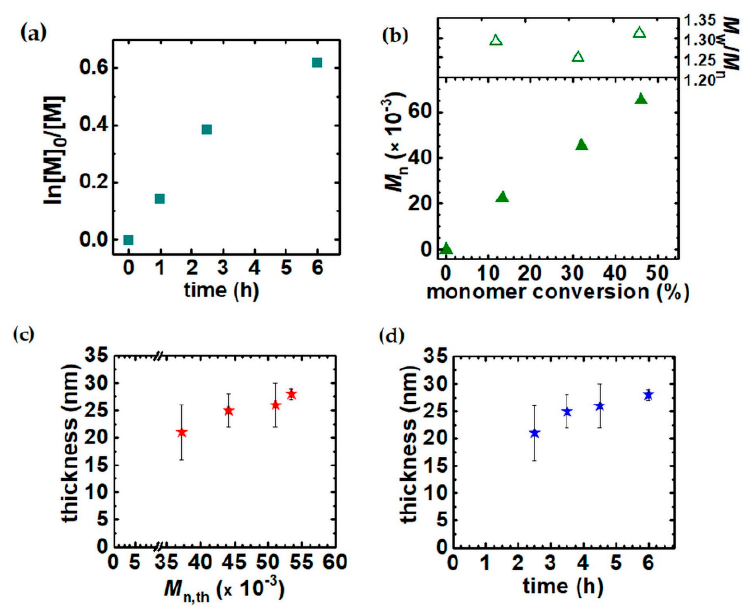
Figure 1. Controlled synthesis of well-defined PHEA brushes grafted from Si-Br. ( a ) First-order kinetic plot of monomer conversion vs. polymerization time. ( b ) M n and M w / M n vs. monomer conversion. ( c ) PHEA brush thickness vs. M n,theo . Table 1, entry 1. ( d ) PHEA brush thickness vs. reaction time. Table 1, entry